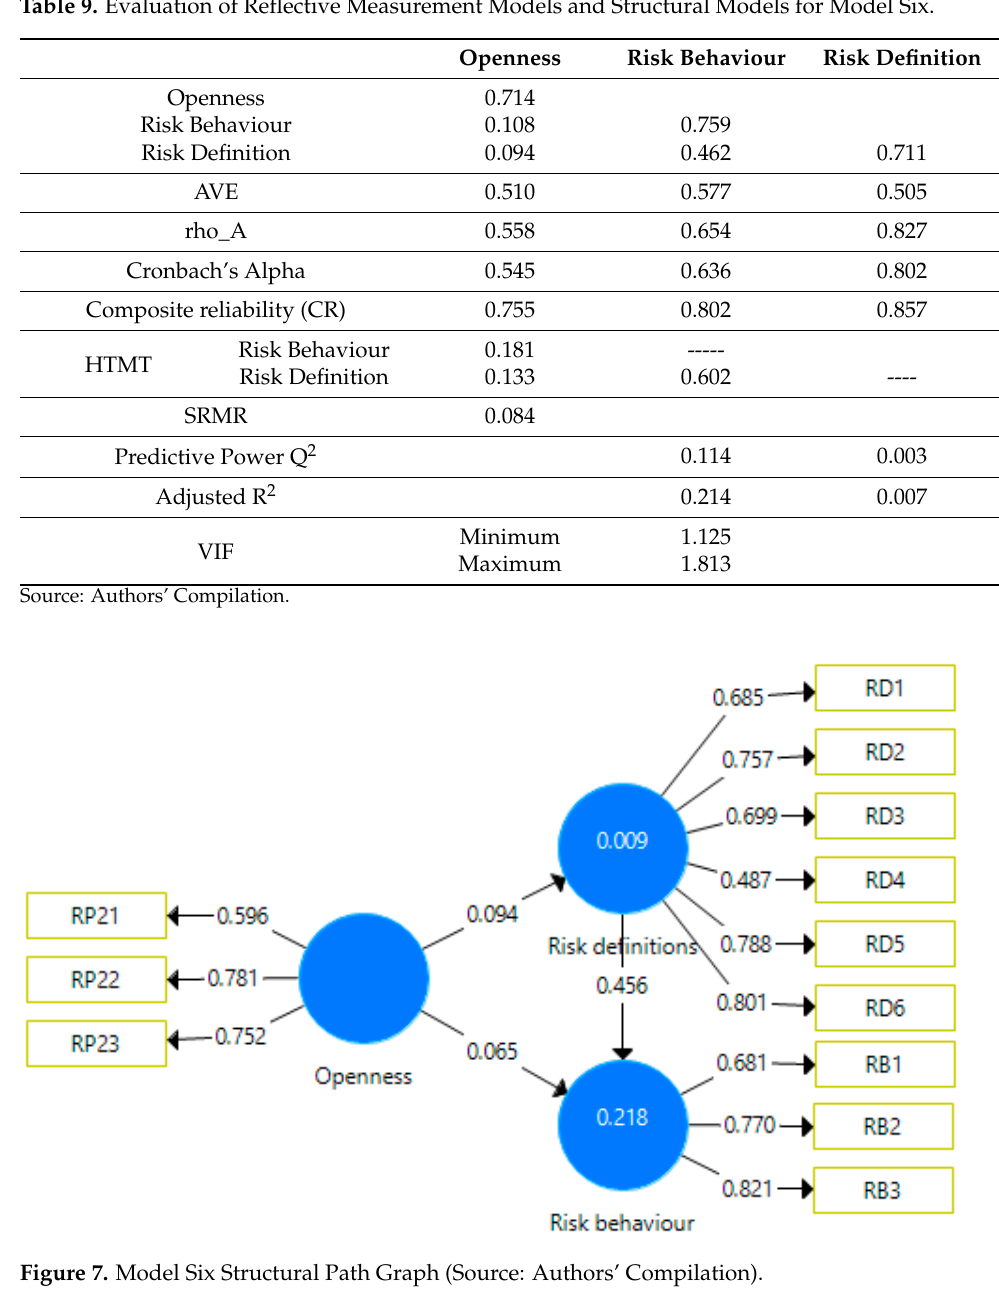
Figure 7. Model Six Structural Path Graph (Source: Authors’